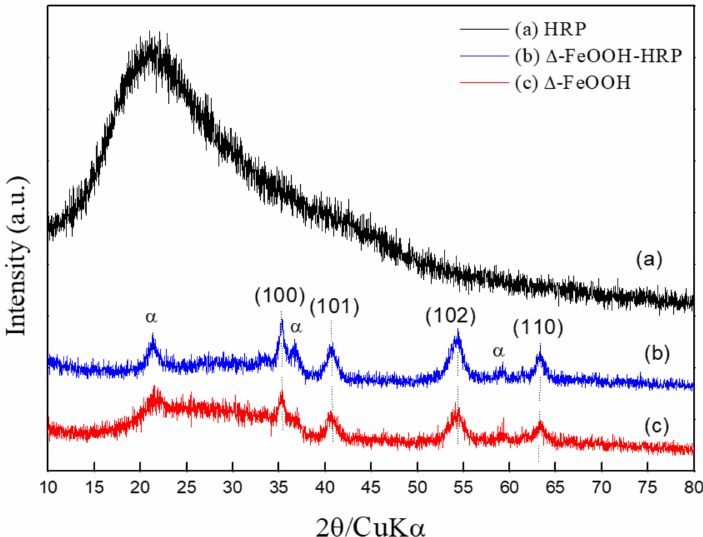
Figure 1. X-ray di ff raction (XRD): ( a ) horseradish peroxidase (HRP); ( b ) ∆ -FeOOH–HRP; ( c ) ∆ -FeOOH